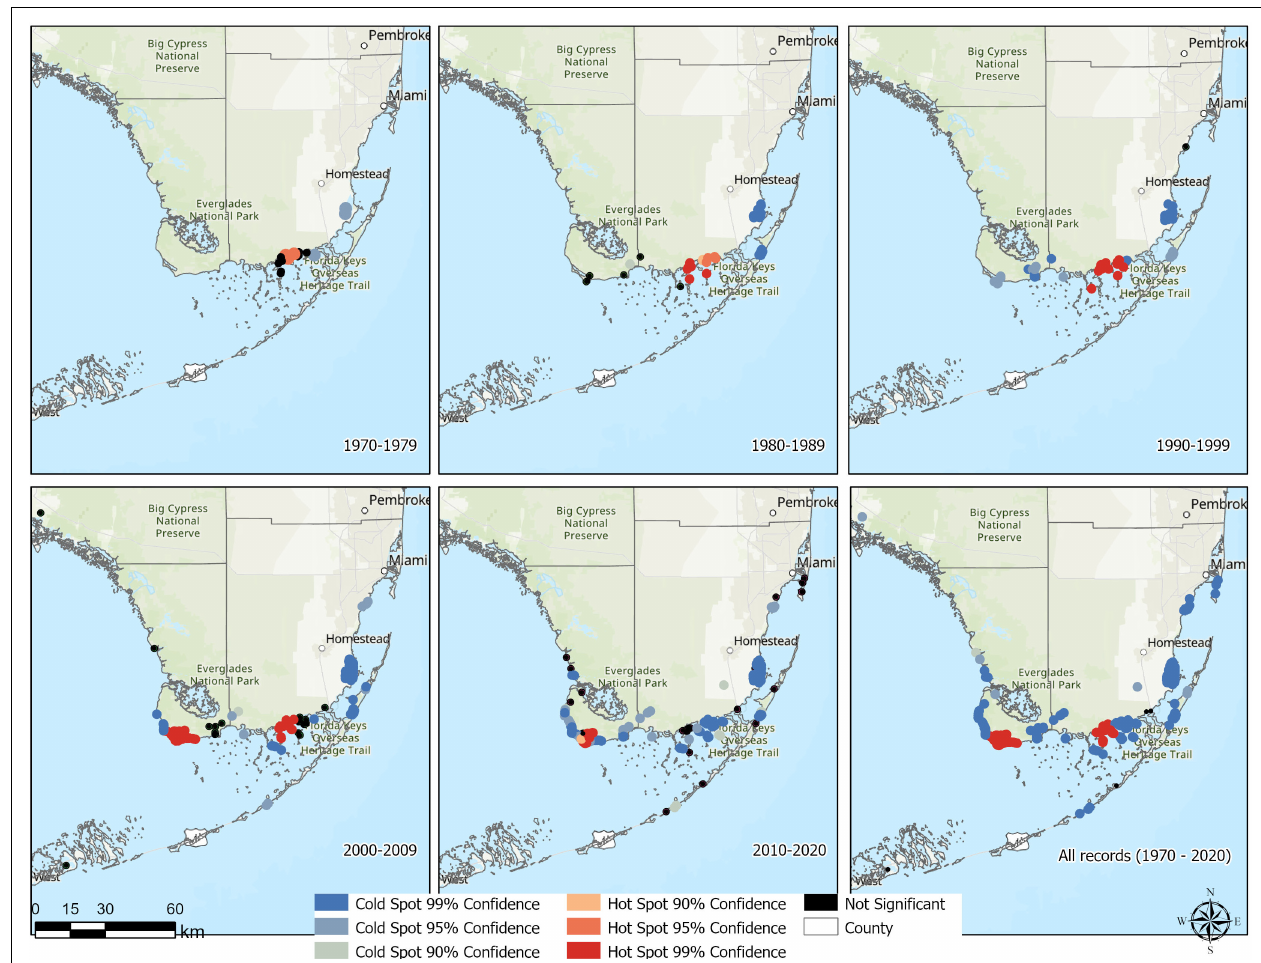
FIGURE 3 | Optimized hot spot analysis of American crocodile ( Crocodylus acutus ) nests registered across South Florida, United States from 1970 to 2020. Red dots represent hot spot areas with different levels of evidence (strong ≤ 99 %, moderate ≤ 95 %, and weak ≤ 90 %) where high incident counts (high and repeated number of nests) cluster based on a specific distance band (see Table 3 for details). In contrast, blue-grayish dots represent cold areas with different levels of evidence where low incident counts (low but repeated number of nests) cluster based on a specific distance